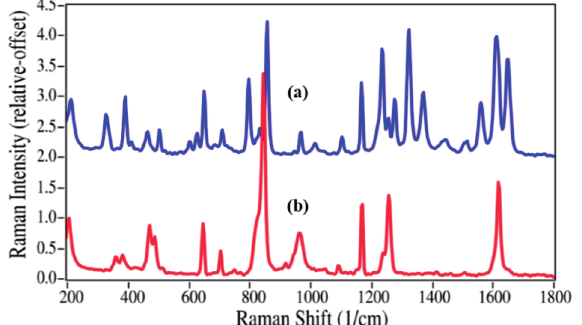
Figure 2. Raman spectra of ( a ) acetaminophen and ( b ) p -aminophenol. Spectral conditions: 500 mW at 1064 nm, 8 cm − 1 resolution, 5 min acquisition (100